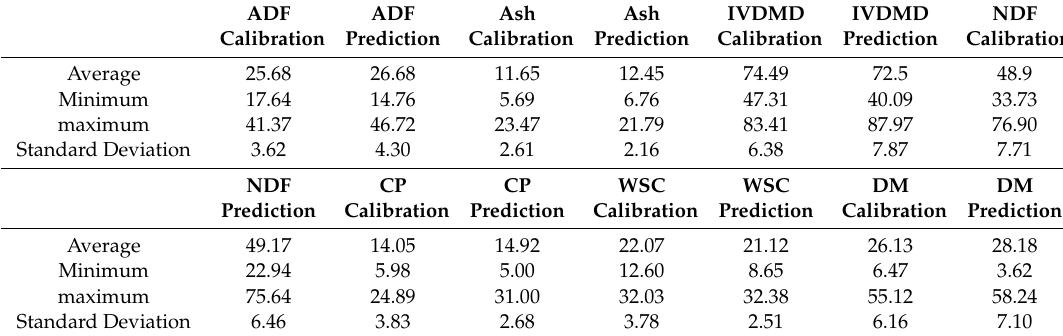
Table 2. The range of NV variables found in the calibration set and the predicted values for the entire sample population. Parameters listed are (ADF), ash, dry matter (DM), crude protein (CP), in vivo